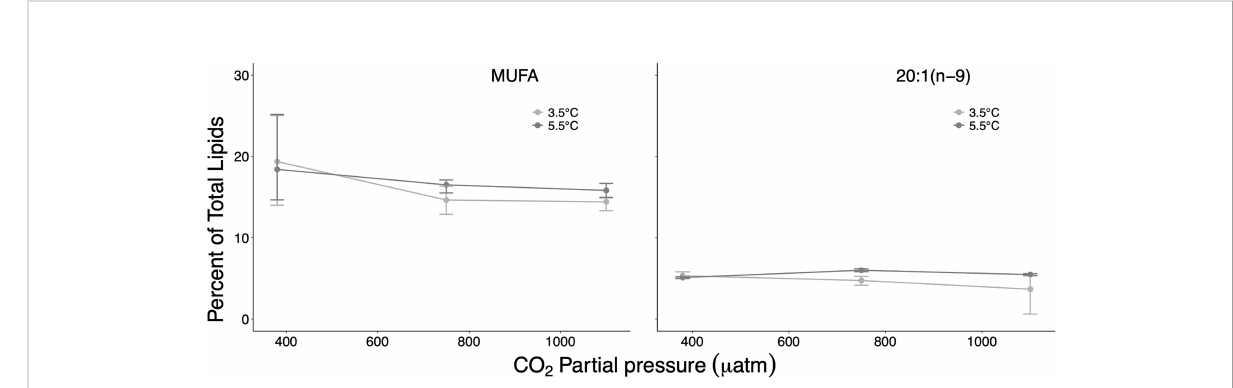
FIGURE 4 Percent contribution of monounsaturated fatty acids (MUFA), and of the dominating MUFA 20:1(n − 9) on total lipids at the different treatment and factor levels. Error bars depict 95% con fi dence